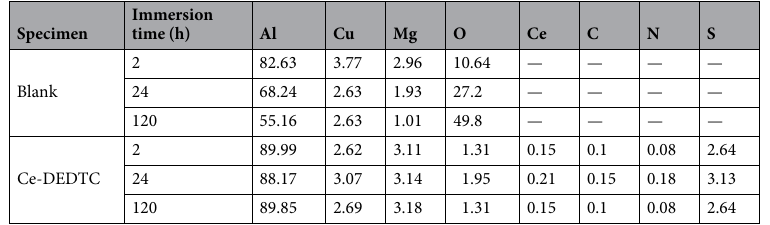
Table 4. The composition of corrosion products (atomic %) formed on the surface of the 2024-T3 aluminum alloy soaked in the 3.5 wt.% NaCl solution and Ce-DEDTC extract solution vs. the immersion